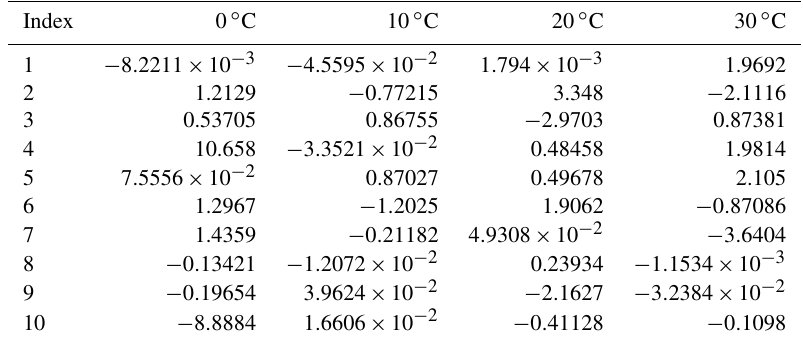
Table A2. Coefficients b 1 − 10 for the ratio A DP /A in Eq. (2). The coefficients were calculated for a 30 ◦